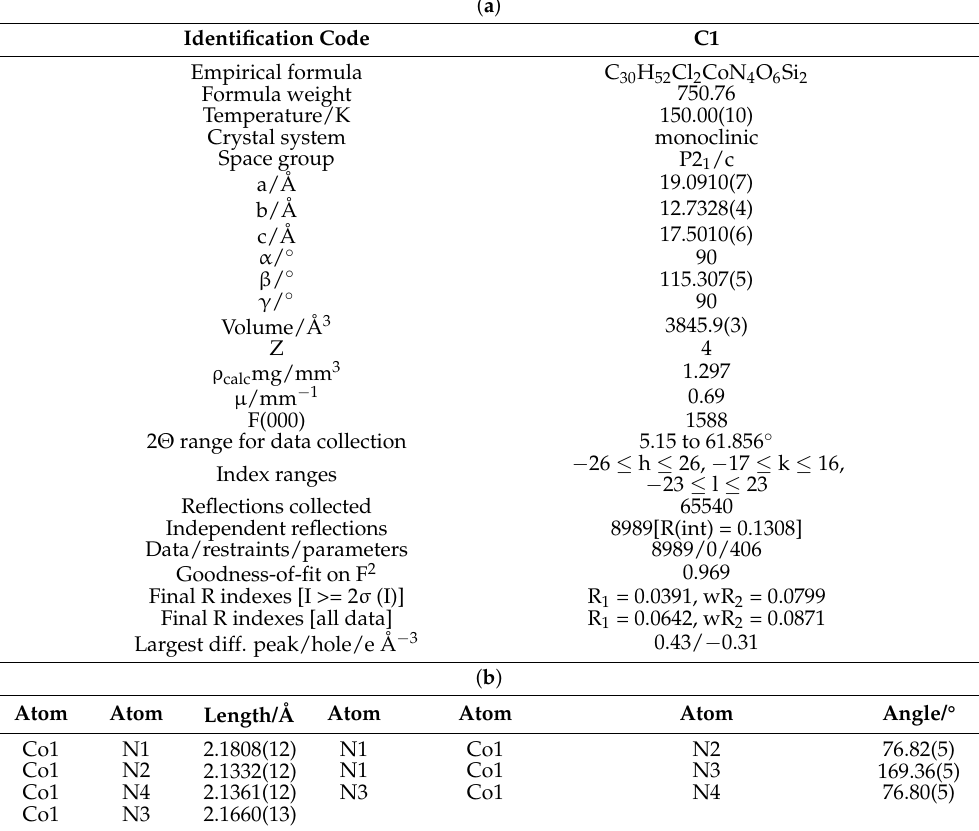
Figure 1. Molecular structure of C1 with thermal ellipsoids. Hydrogen atoms are omitted for clarity. Table 1. ( a ) Crystal data and structure refinement for C1 . ( b ) Selected bond Lengths and bond angles for C1 .